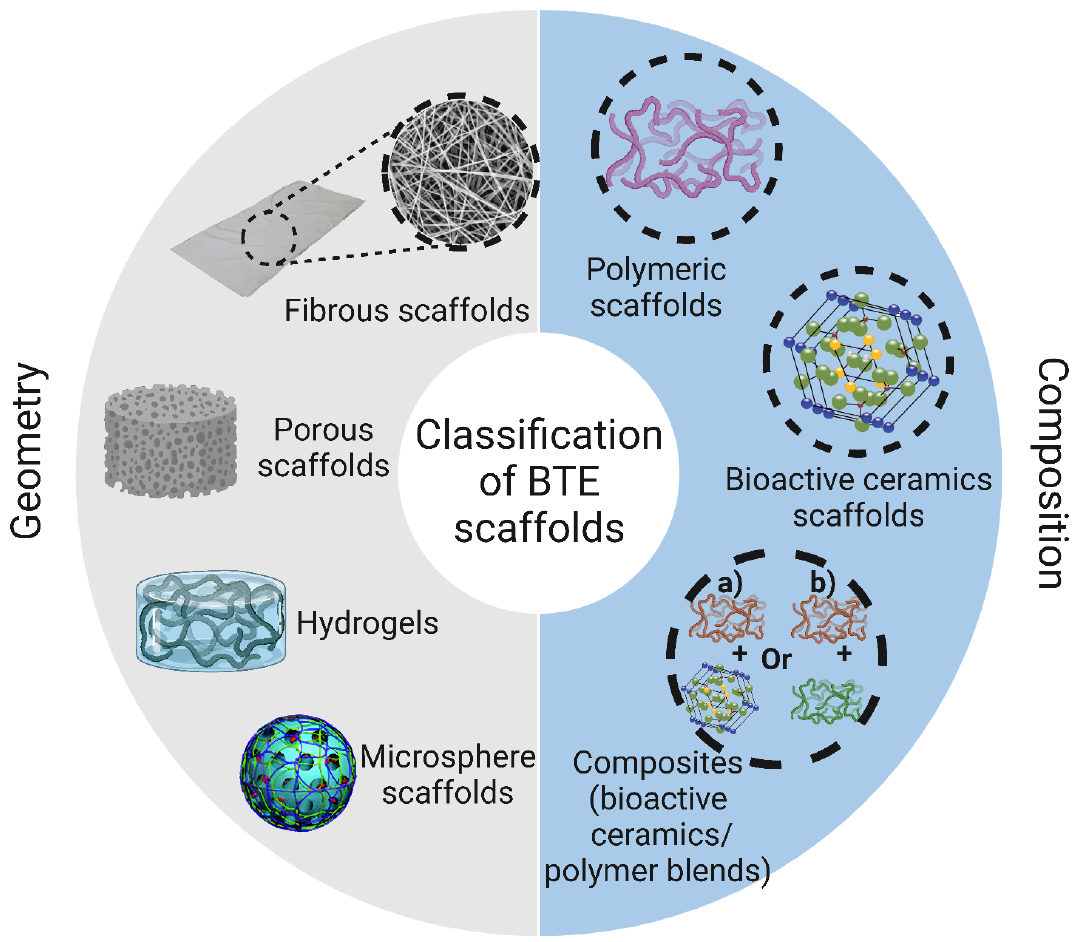
Figure 8. Classification of polymeric scaffolds used in bone tissue engineering according to their geometry and composition. The image was created using Biorender.